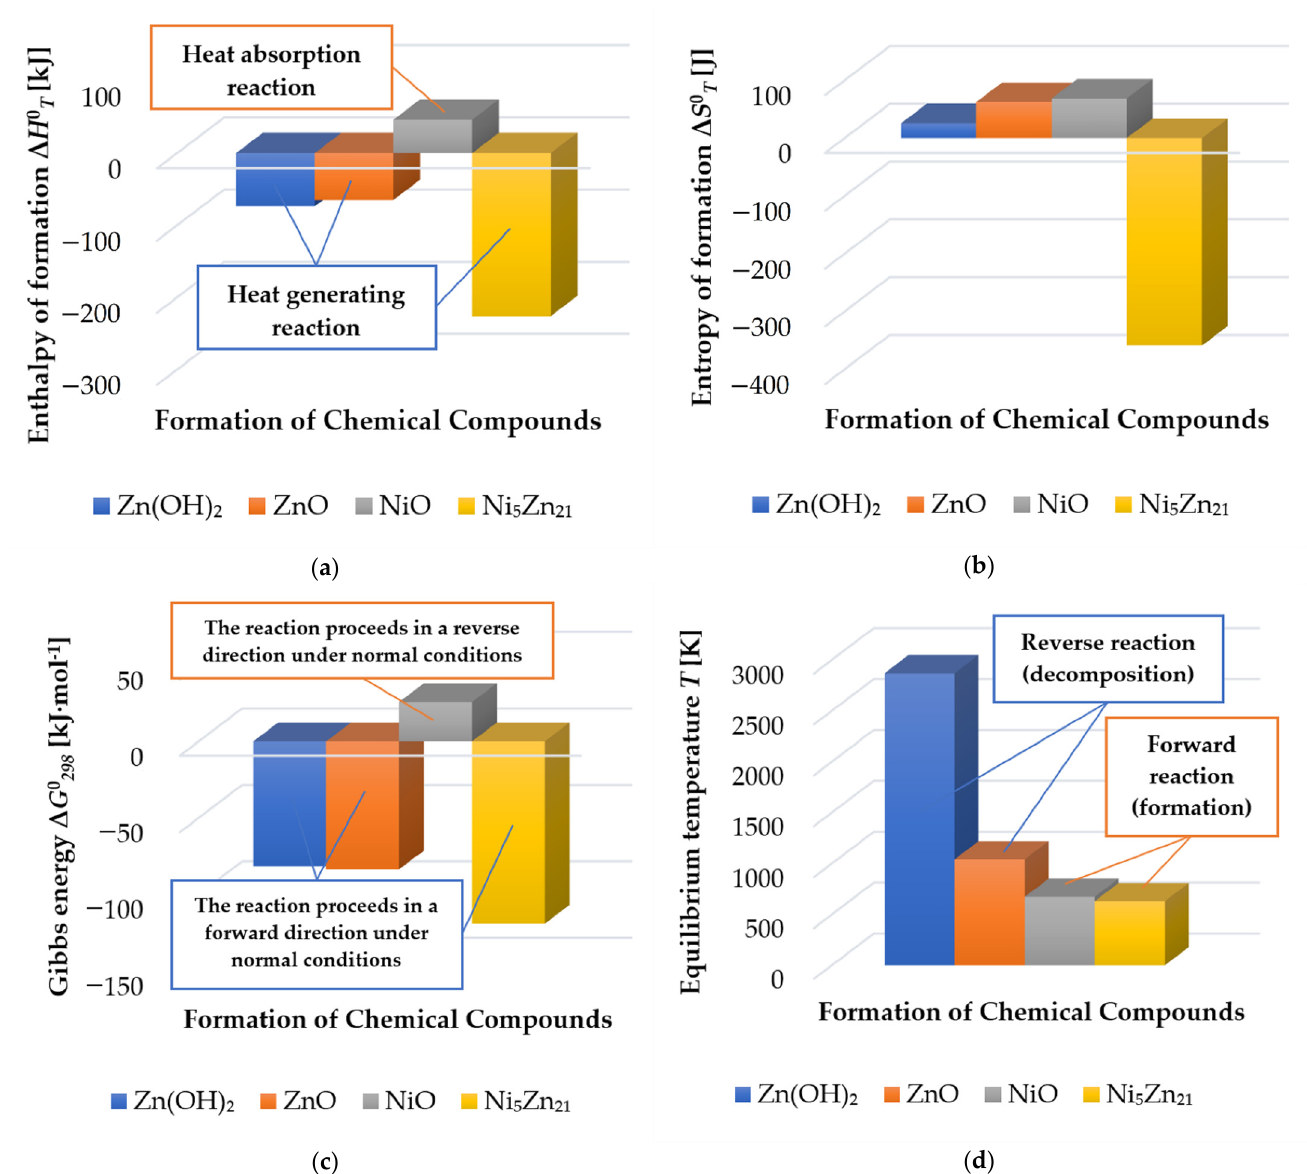
Figure 6. Thermochemical parameters of chemical reactions of nickel and zinc in a water medium: ( a ) enthalpy of formation; ( b ) entropy of formation; ( c ) Gibbs energy; ( d ) equilibrium temperatures.